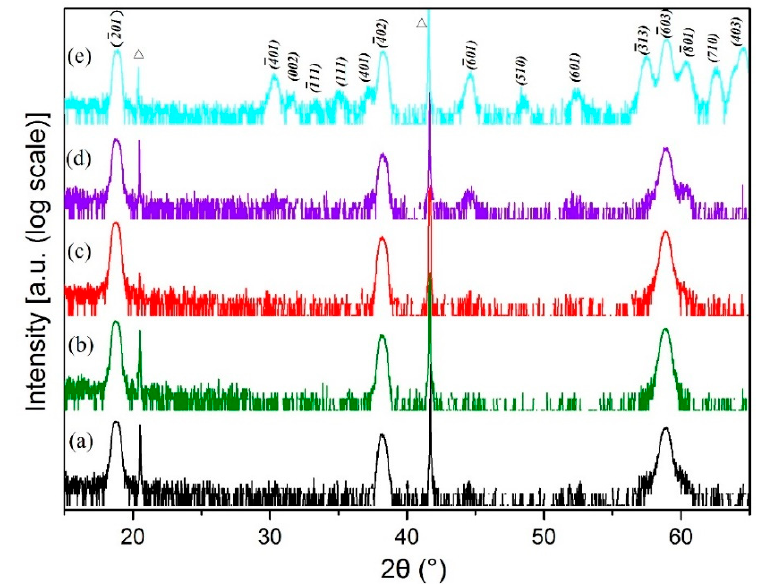
Figure 2. XRD θ –2 θ scan patterns of β -Ga 2 O 3 films grown with various VI / III ratios: ( a ) 66.9 × 10 3 ; ( b ) 22.3 × 10 3 ; ( c ) 11.2 × 10 3 ; ( d ) 7.4 × 10 3 ; ( e ) 5.6 × 10 3 . ∆ the peaks of the sapphire substrates.